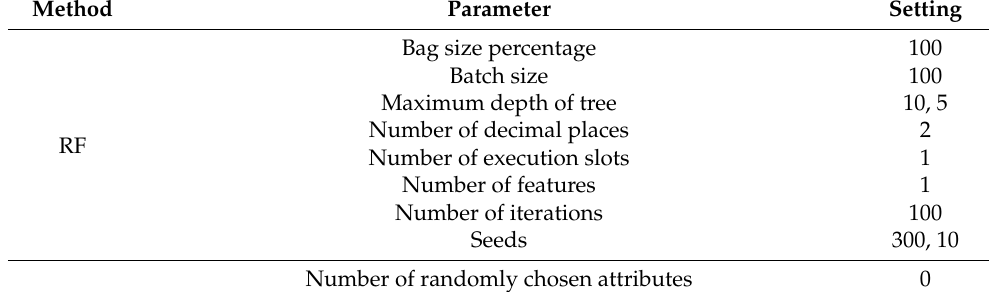
Table 1. Optimized values of parameters of different